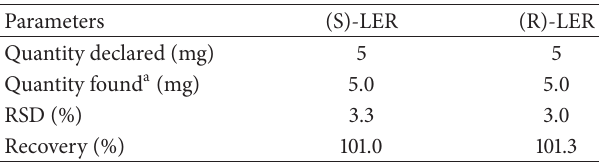
Table 6: Determination of LER enantiomers in samples of commer- cial